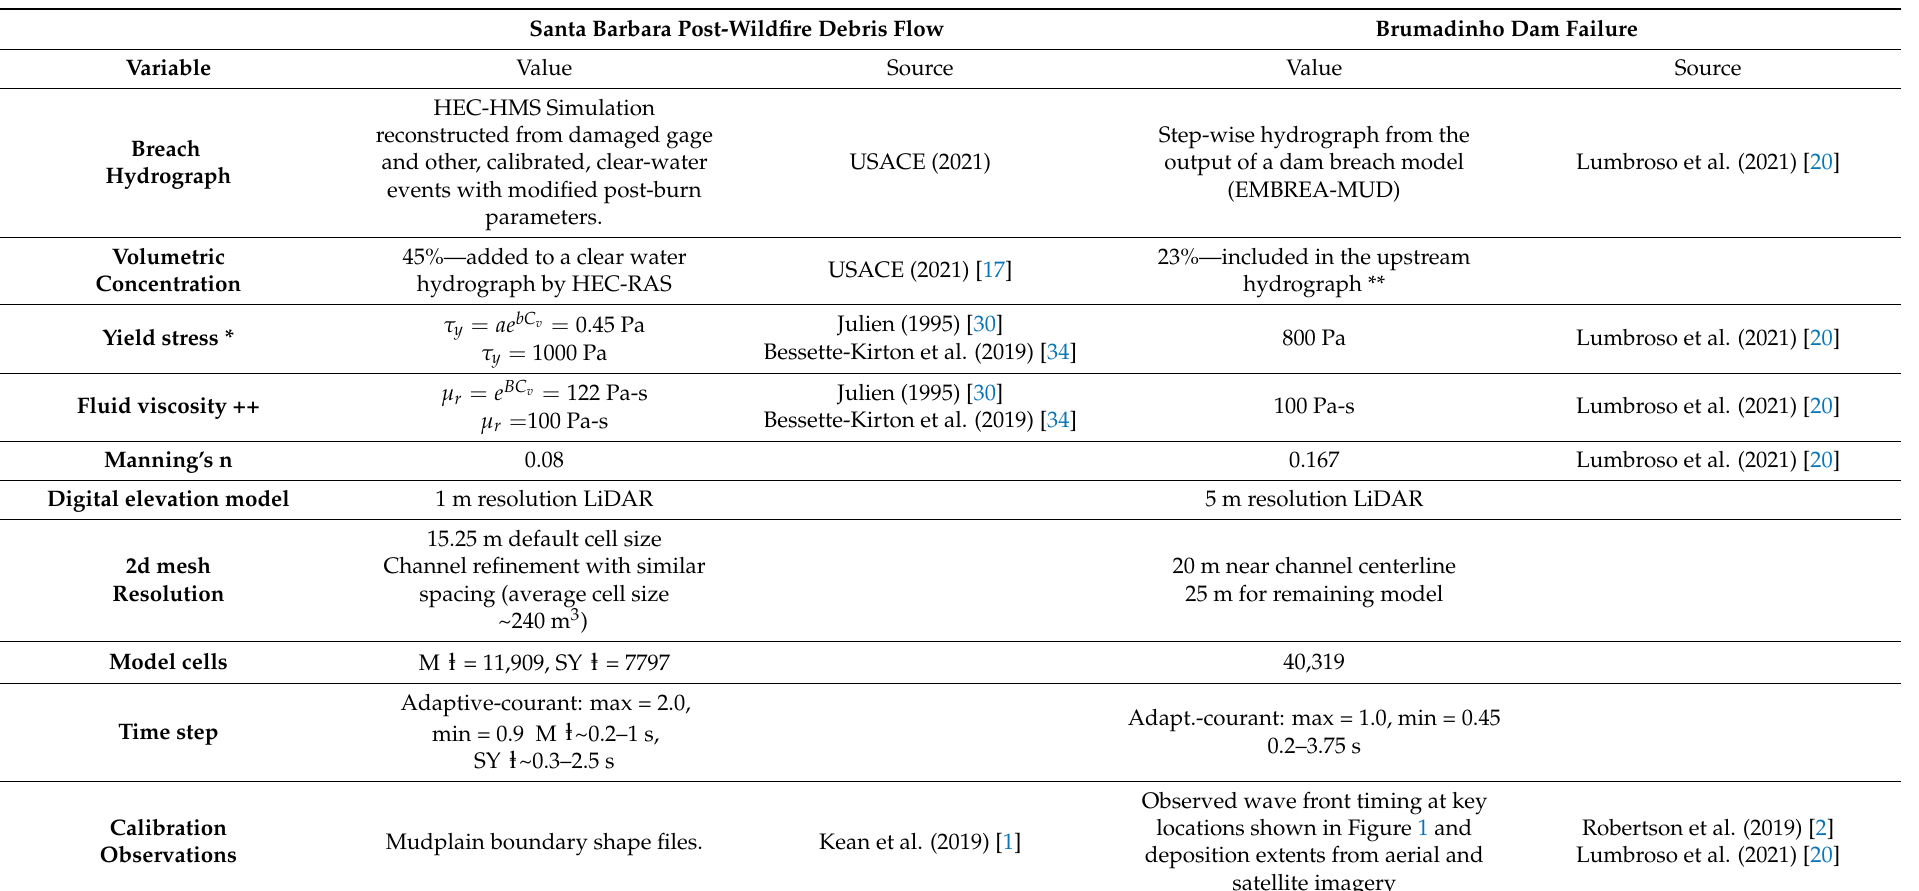
Table 1. Key parameters and values used in HEC-RAS non-Newtonian model of the Brumadinho mine tailings failure.